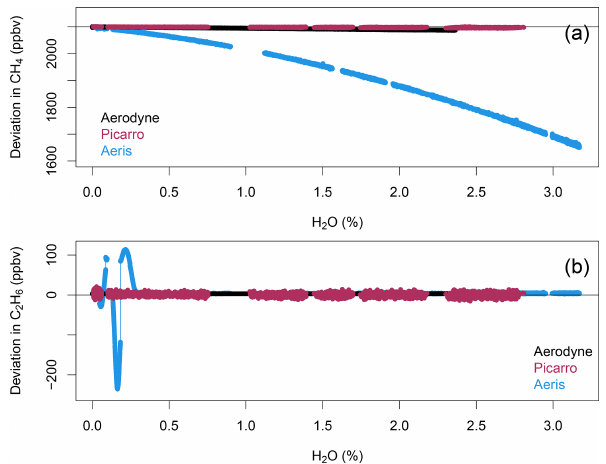
Figure 1. Uncorrected (a) methane (ppbv) and (b) ethane (ppbv) vs. water vapor (%) for the Aerodyne SuperDUAL (black), Picarro G2210-i (red), and Aeris MIRA Ultra LDS